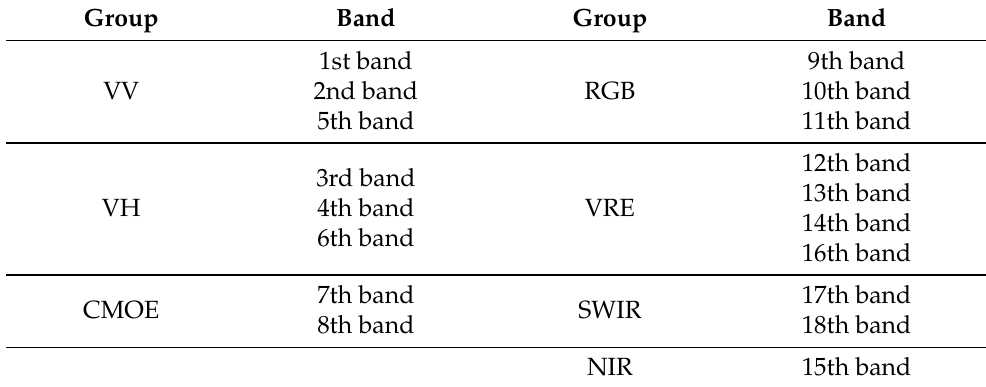
Table 2. Band-grouping